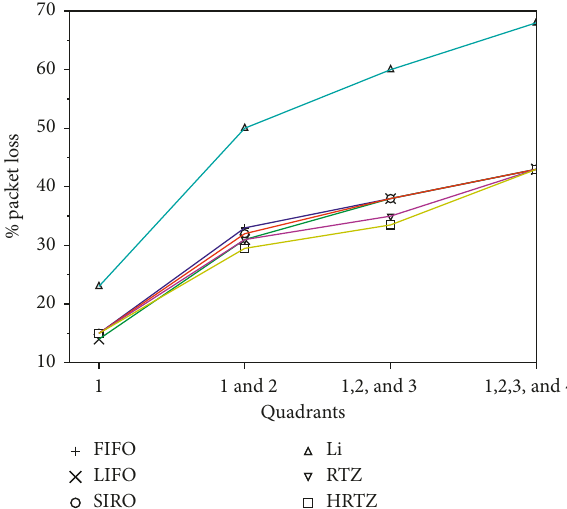
Figure 7: The cumulative percentage of packet loss with respect to different locations and directions (quadrant) of transmitting vehicles.